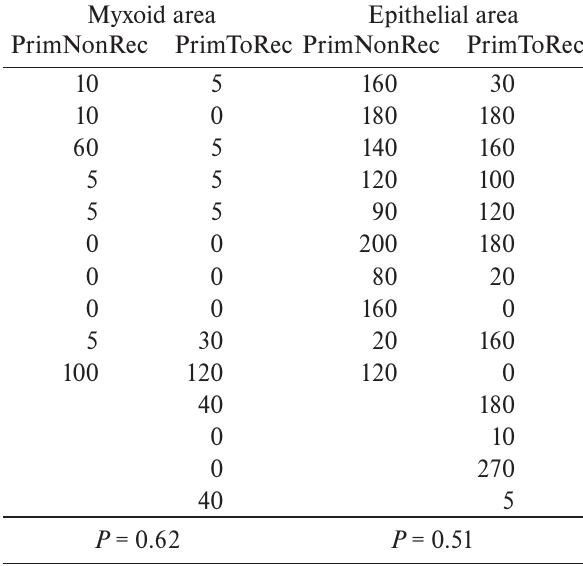
Table 2. Bcl-2 histoscore of myxoid areas of primary-to-recur (PrimToRec) pleomorphic adenomas and corresponding first (RecTumour) and consequent